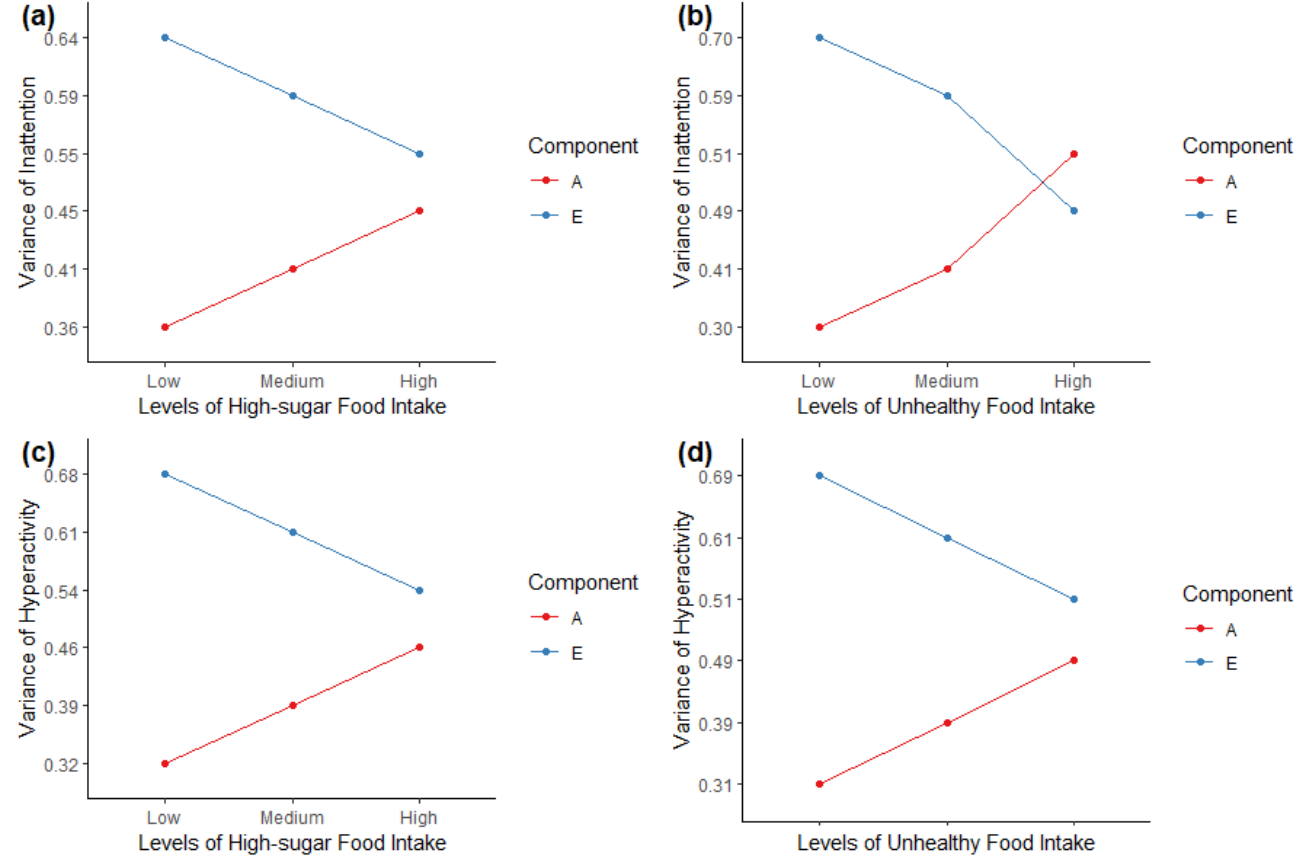
Figure 2. Genetic (A) and non-shared environmental (E) variance of ADHD symptoms change with different levels of high-sugar and unhealthy food intake. ( a ) Full moderation model for inattention and high-sugar food; ( b ) Full moderation model for inattention and unhealthy food; ( c ) Full mod- eration model for hyperactivity/impulsivity and high-sugar food; ( d ) Full moderation model for hyperactivity/impulsivity and unhealthy food.